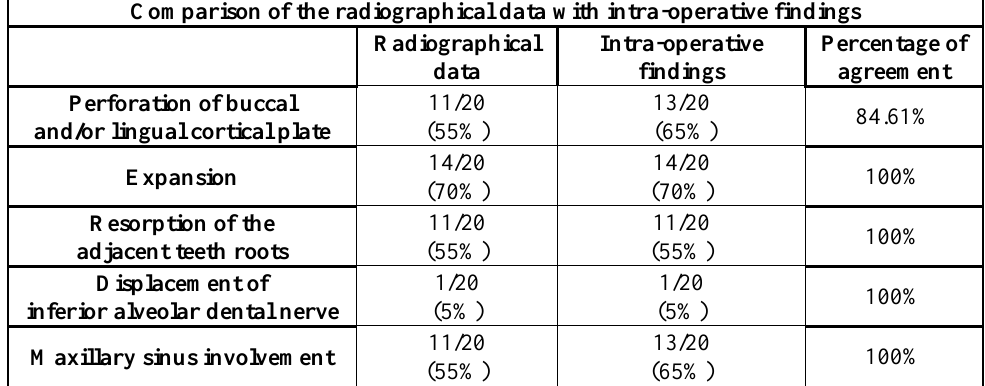
Table 2: Statistical analysis of radiographical data versus intra-operative data with percentage of agreement for each record